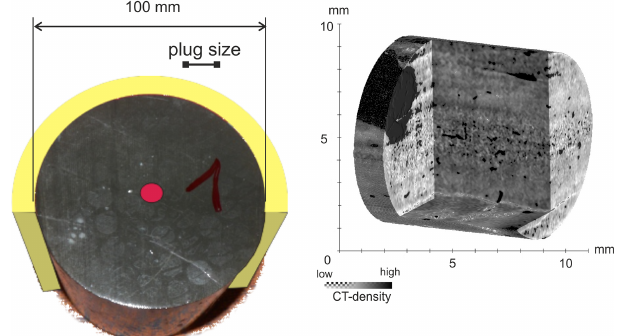
Figure 1. Left: OPA drill core before it is embedded in resin (“plug size” refers to the dimensions of the µ -CT image). Right: µ -CT im- age of a mini-plug from the same formation (recorded at the Federal Institute for Material Research and Testing BAM, Berlin). Figure taken from Kulenkampff et al.